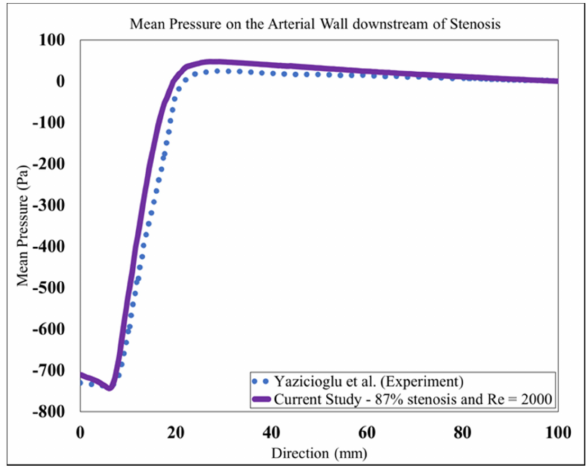
Figure 4. Mean Pressure on the arterial wall in the post-stenotic